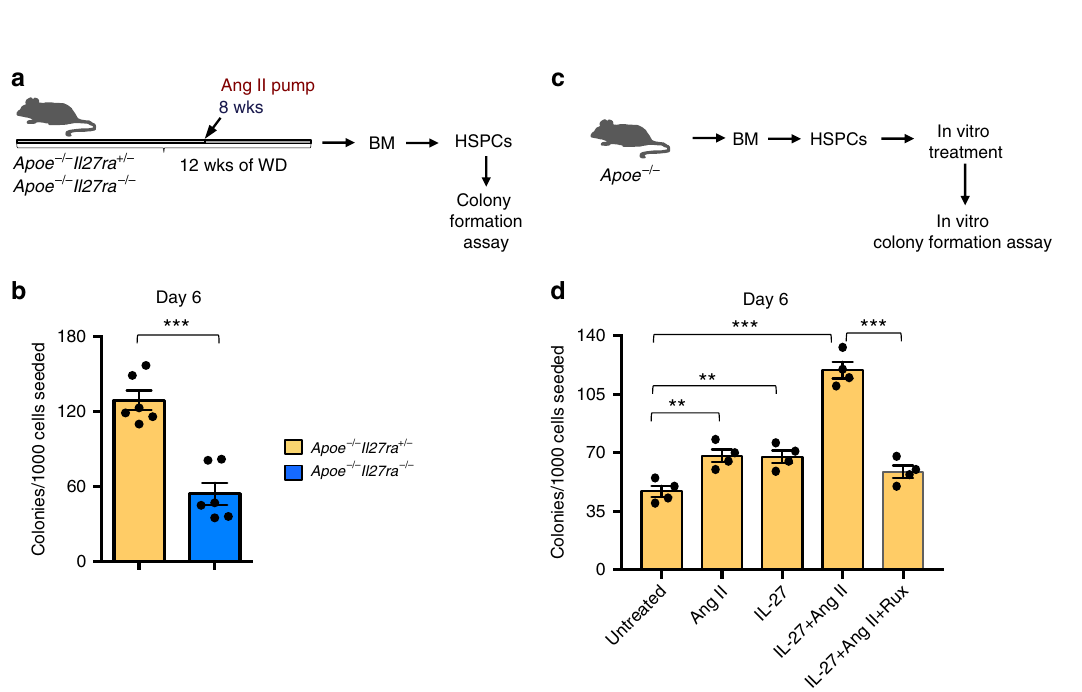
Fig. 4 IL-27R signaling is needed for HSPC differentiation. a Scheme of ex vivo colony-formation experiment. b Lin − HSPCs were isolated from BM of Apoe − / − Il27ra + / − ( n = 6) or Apoe − / − Il27ra − / − ( n = 6) mice infused with Ang II and plated in M3434 media under myeloid conditions. Granulocyte – monocyte (GM) colony formation was accessed on day 6. c Scheme of in vitro colony-formation experiment. d Lin − HSPCs were isolated from BM of Apoe − / − ( n = 4) mice and plated in M3434 media under myeloid conditions in the presence of Ang II, recIL-27, Ruxolitinib, or their combination. GM colony formation was accessed on day 6. Data are mean ± SEM from three independent experiments. ** p < 0.01, *** p < 0.005, unpaired Student ’ s t -test